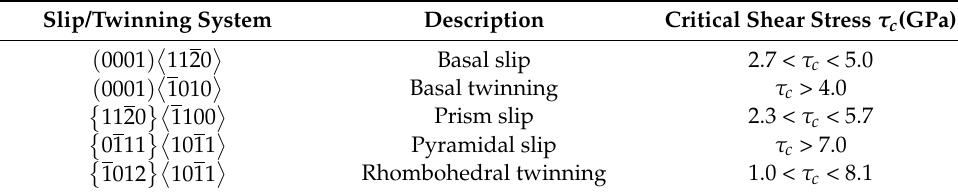
Table 1. Slip/twinning systems and critical shear stresses for sapphire [14,19,21].